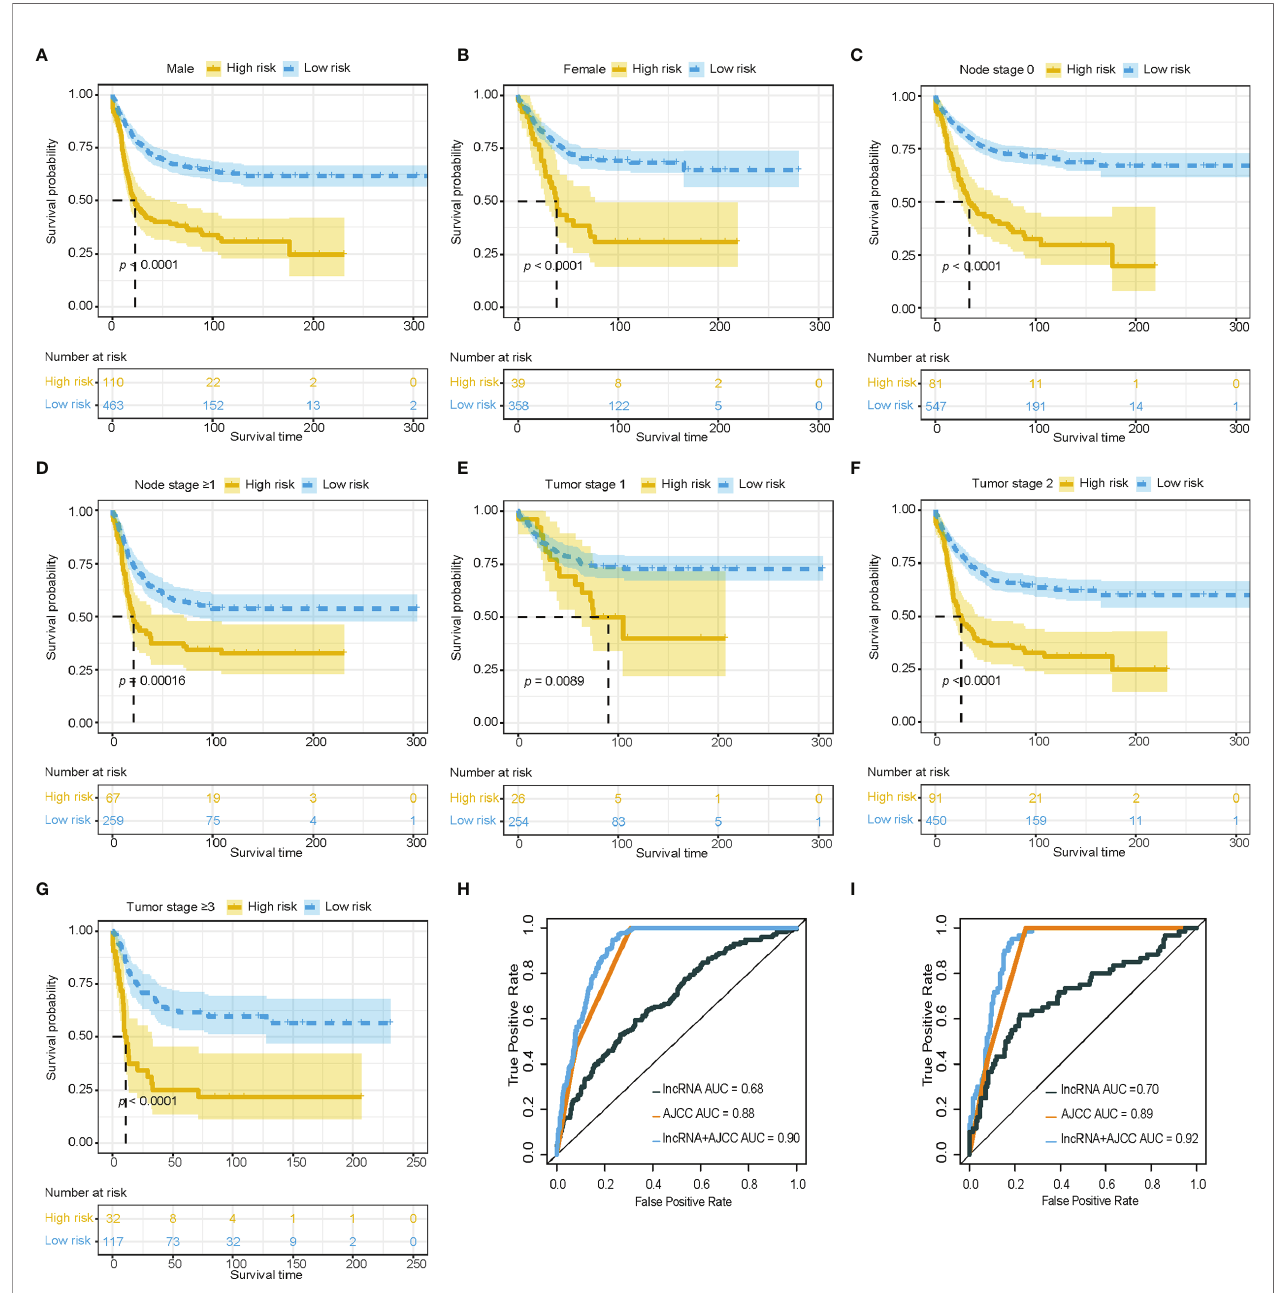
FIGURE 2 | Clinical value of immune-related lncRNA model. (A – G) Survival analysis showed favorable survival for low-risk patients in different gender, node stage, and tumor stage. (H, I) Receiver operating characteristic curves were used to compare the predictive ef fi cacy of the immune-related lncRNA based model alone, AJCC TNM staging alone, and the combination model in training cohort and validation cohort. lncRNA, Long non-coding RNA; AJCC, American Joint Committee on Cancer; TNM staging, Tumor, Node, and metastasis staging